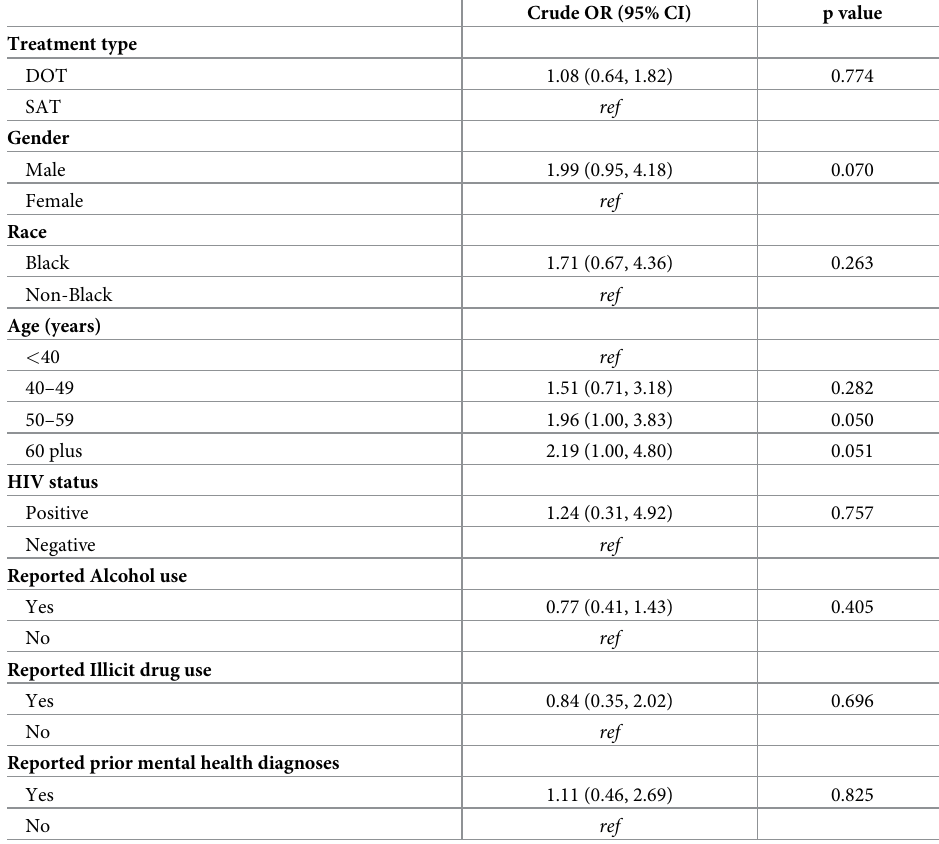
Table 4. Bivariate associations between patient characteristics at baseline and treatment completion (Unweighted sample) among 274 homeless persons on 4 months rifampin for latent TB infection treatment in Fulton County, GA